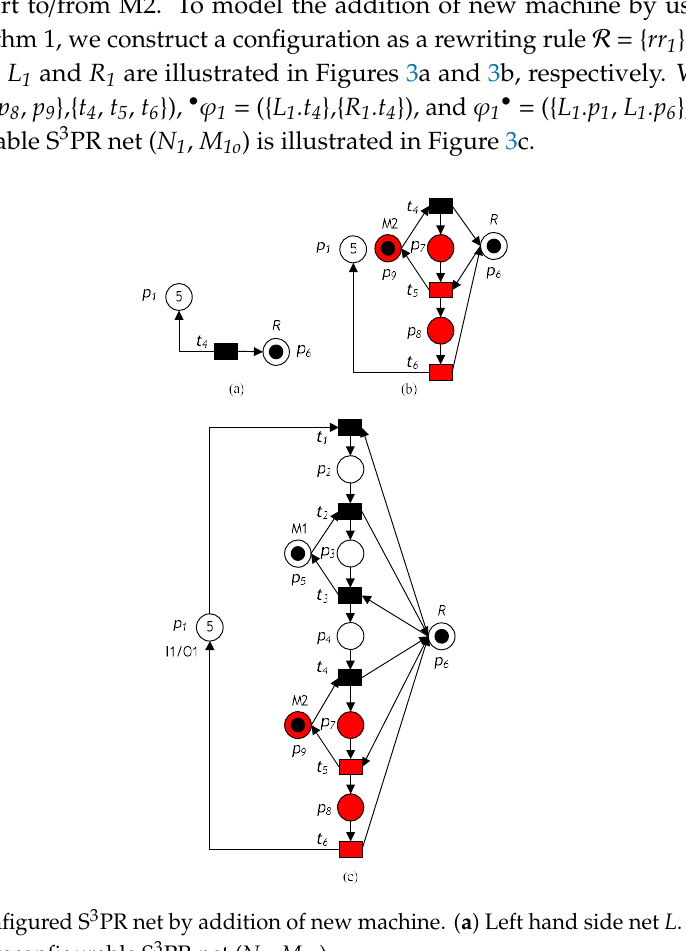
Figure 3. A reconfigured S 3 PR net by addition of new machine. ( a ) Left hand side net L . ( b ) Right